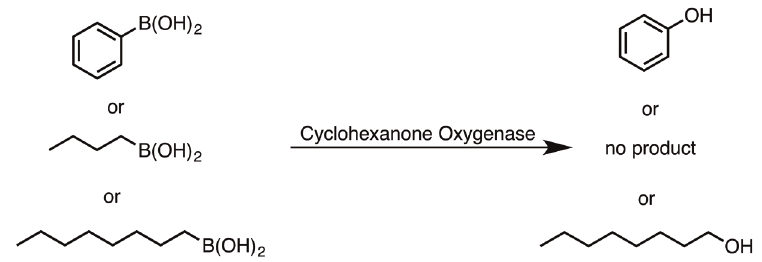
Figure 48 - Oxidation of boronic acids by cyclohexanone oxygenase.